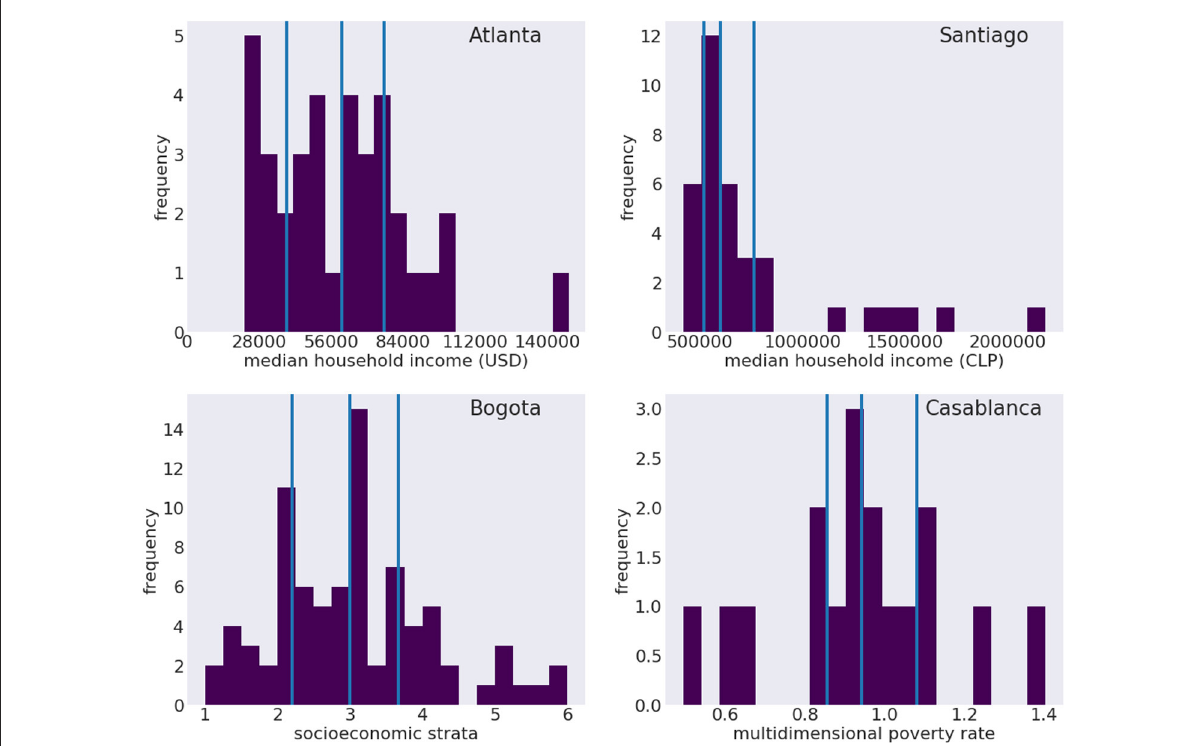
FIGURE3 Histograms of socioeconomic indicators distributions in the cities of Atlanta, Santiago, Bogotá and Casablanca. From top to bottom: median household income in Atlanta, USA, by zip code; median household income in Santiago, Chile, by comuna; socioeconomic strata in Bogotá, Colombia, by UPZ; multidimensional poverty rate, in Casablanca, Morocco, by arrondissement. Vertical solid lines indicate to the quartiles of the distributions.